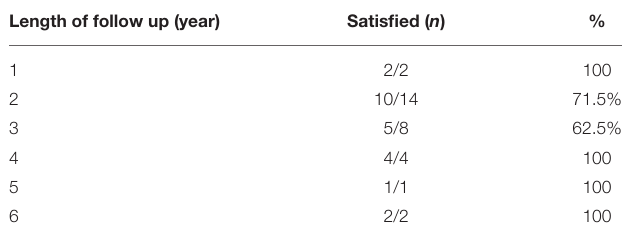
TABLE 2 | Satisfaction despite year of follow